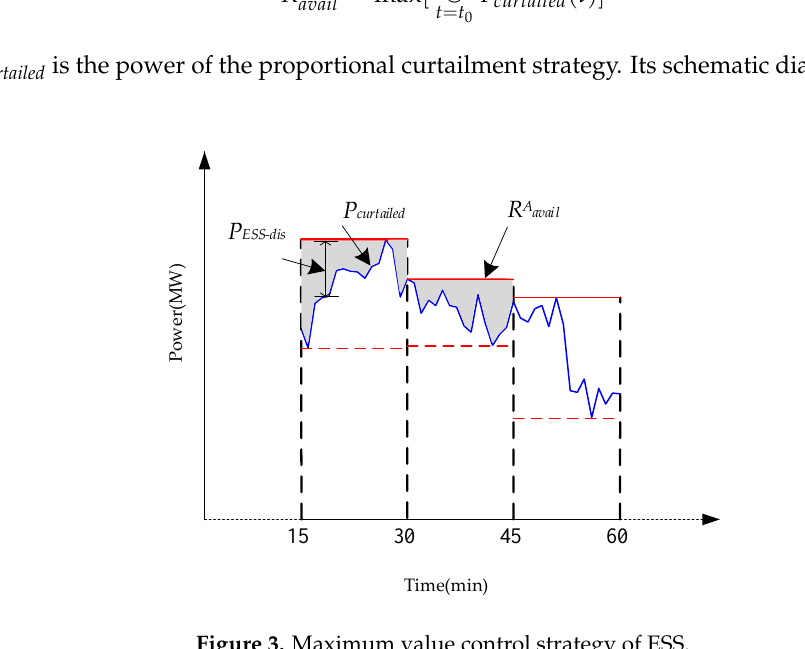
Figure 3. Maximum value control strategy of ESS.